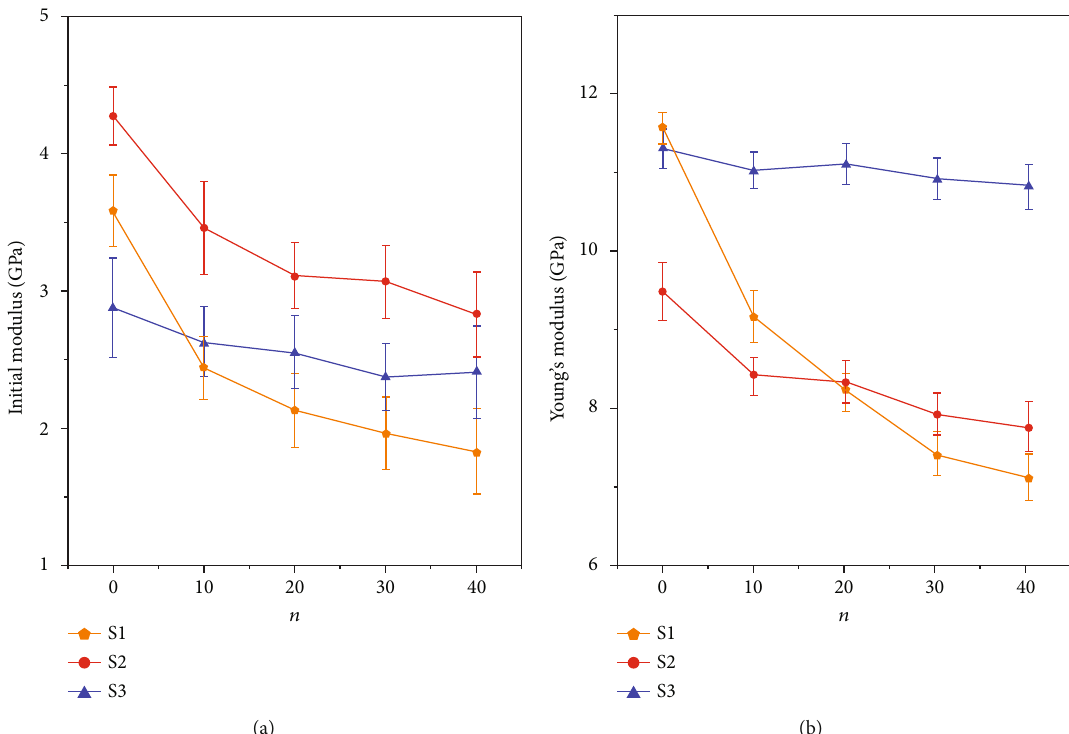
Figure 6: Variation in (a) initial modulus and (b) Young ’ s modulus of tested sandstones versus the number of WD cycles.